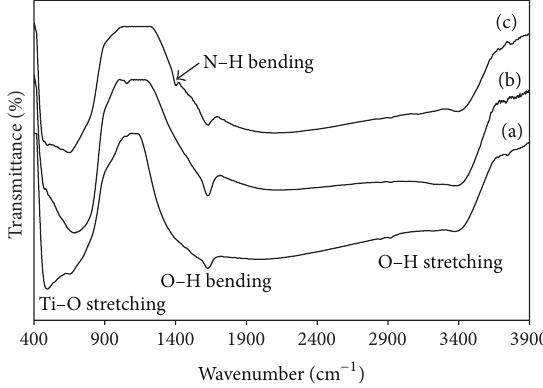
Figure 4: FTIR spectra of (a) pure TiO 2 , (b) 3SnO 2 /TiO 2 , and (c) 20N/3SnO 2 /TiO 2 powders calcined at 600 ∘